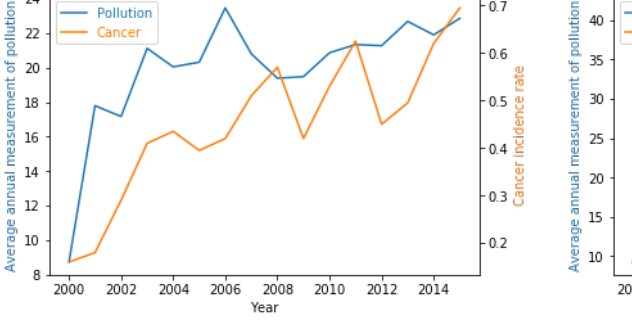
Figure 4. Cases of death as a result of malignant neoplasms in Poland in the years 1999–2015. On the left—men; on the right—women. Source: National Cancer Registry [10].